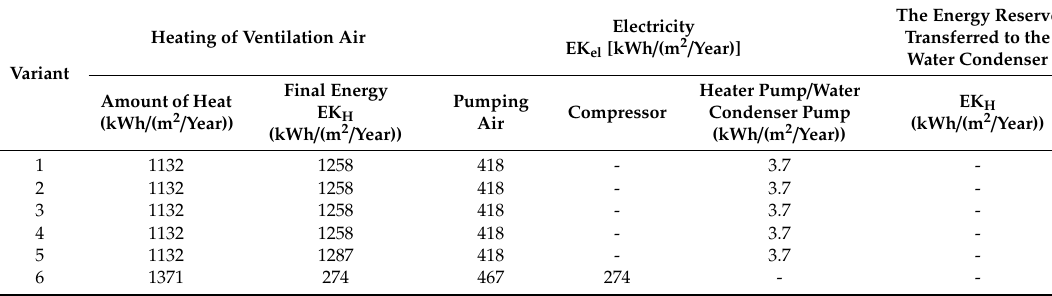
Table 6. Energy consumption calculation results—recreation pool